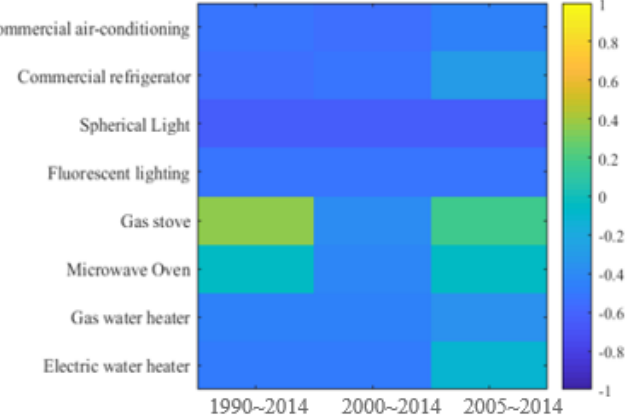
Figure 9. Correlation between equipment energy efficiency improvement and CO 2 emission of tertiary industry in different stages.